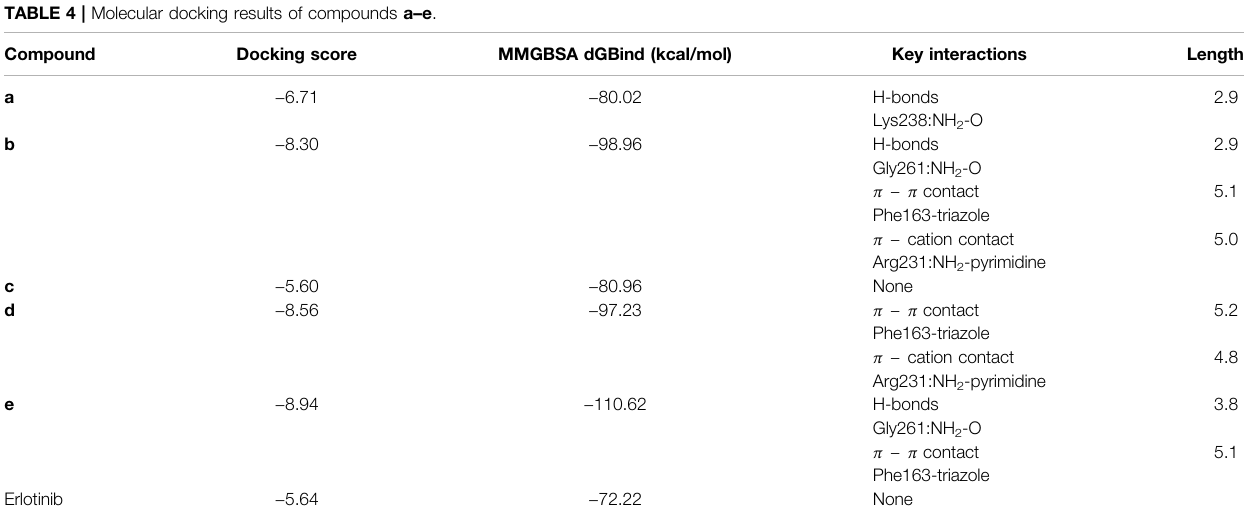
TABLE 4 | Molecular docking results of compounds a – e . Compound Docking score MMGBSA dGBind (kcal/mol) Key interactions Length(Å)